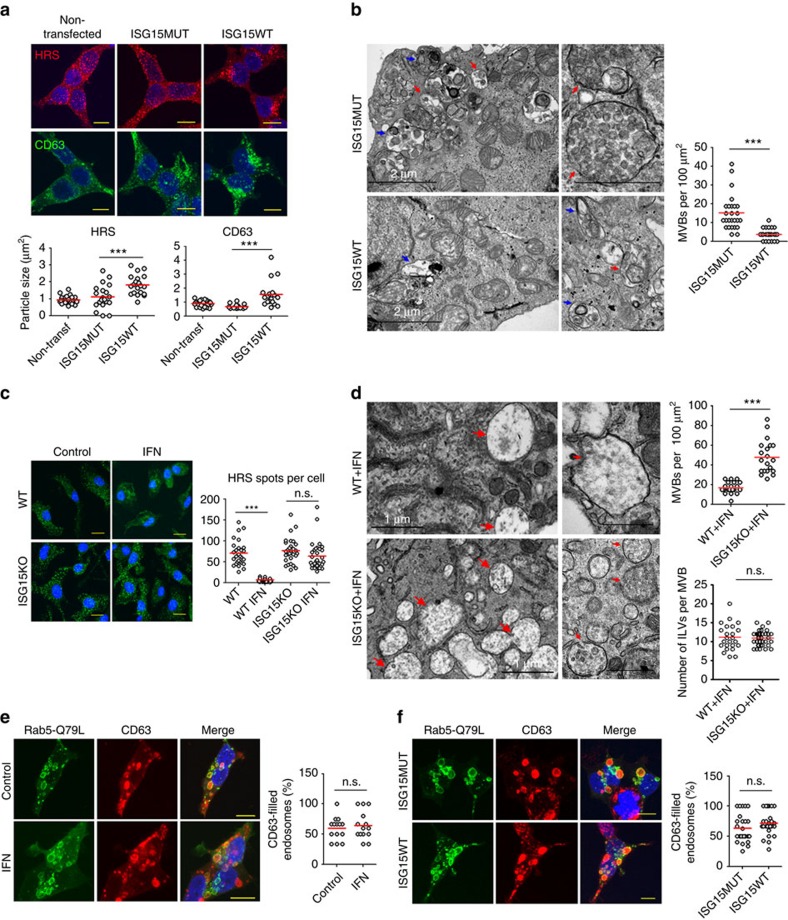
ISGylation decreases MVB numbers.(a) Confocal microscopy analysis of the endosome markers HRS (red) and CD63 (green) in non-transfected HEK293 cells or HEK293 cells co-transfected with plasmids encoding the ISGylation machinery and the functional (ISG15WT) or mutated ISG15 (ISG15MUT). Scale bar, 10 μm. Right graph: quantification of HRS+ and CD63+ average particle size per cell (n=20). Each dot represents the average particle size from individual cells and mean is indicated in red lines. (b) Electron microscopy images showing representative fields with MVBs (red arrows) and lysosomes/autophagosomes (blue arrows) in HEK293 transfected as in a. Right graph: quantification of MVB numbers in more than 25 fields per condition. Each dot represents the number of MVBs per section and mean is indicated in red lines. Scale bar (insets), 500 nm. (c) Confocal microscopy analysis of HRS in WT or ISG15KO BMDMs left untreated or treated with 1,000 U ml−1 IFN for 16 h. Scale bar, 10 μm. Right graph: quantification of the number of HRS+ particles per cell. Each dot represents the number of HRS+ particles from individual cells and mean is indicated in red lines (n=28). (d) Electron microscopy images showing MVBs (red arrows) in WT or ISG15KO BMDMs treated with 1,000 U ml−1 IFN for 16 h. Upper graph, quantification of MVB numbers in 20 fields per condition. Each dot represents the number of MVBs per section and mean is indicated in red lines. Lower graph, quantification of ILV numbers per MVB. Each dot represents the number of ILVs per MVB and mean is indicated in red lines (n≥24). Scale bar (insets), 500 nm. (e) Confocal microscopy analysis of CD63 (red) in Rab5-Q79L-GFP+ endosomes (green). HEK293 cells were transfected with Rab5-Q79L-GFP and treated 16 h with 1,000 U ml−1 IFN or left untreated. (f) Confocal microscopy analysis of CD63 (red) in Rab5-Q79L-GFP+ endosomes (green). HEK293 cells were co-transfected with Rab5-Q79L-GFP mutant, the ISGylation machinery and ISG15WT or ISG15MUT. Images from e,f: Scale bar, 10 μm. Right graphs: each dot represents the percentage of CD63-filled endosomes per individual cell and mean is indicated in red lines; t-test; NS: P-value>0.05 and ***P-value<0.0001.